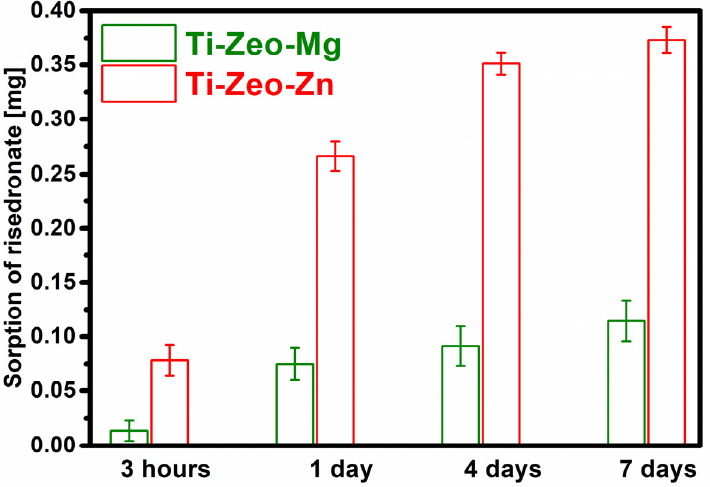
Figure 6. Amount of drug retained on prepared materials (the graph shows the mean values and standard deviation) (three repetitions were performed for each standard deviation) (three repetitions were performed for each material).